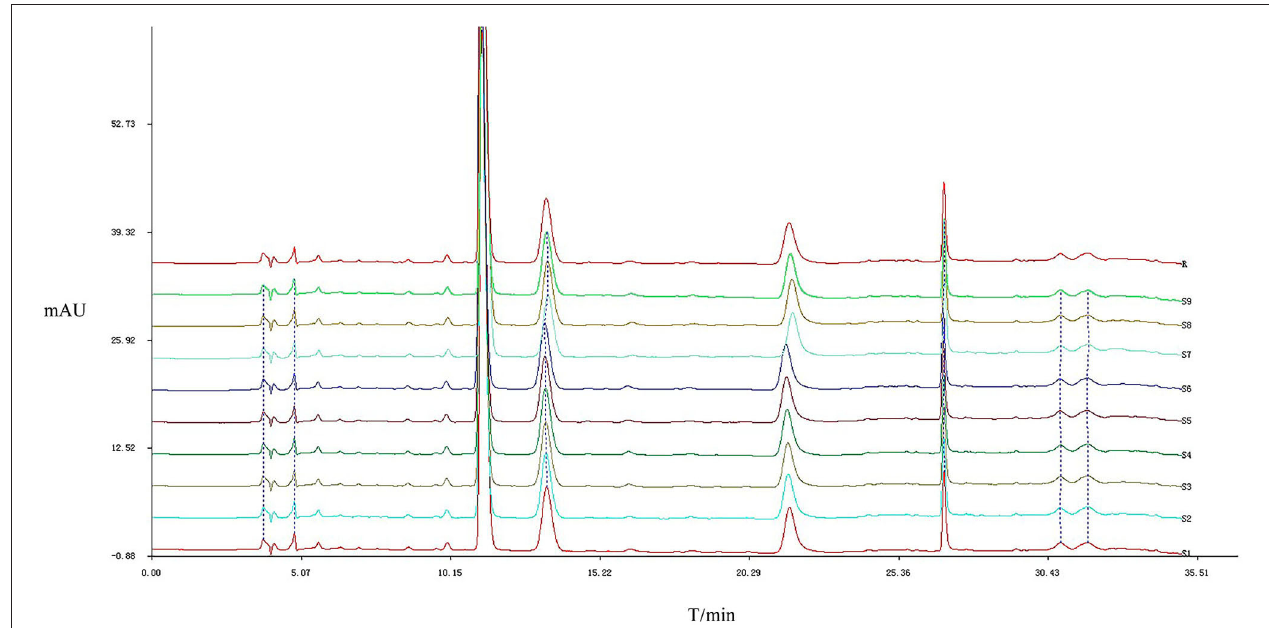
FIGURE 2 | Characteristic chromatograms of different batches of MPTA. The horizontal coordinate is the retention time. The vertical coordinate is the signal value.